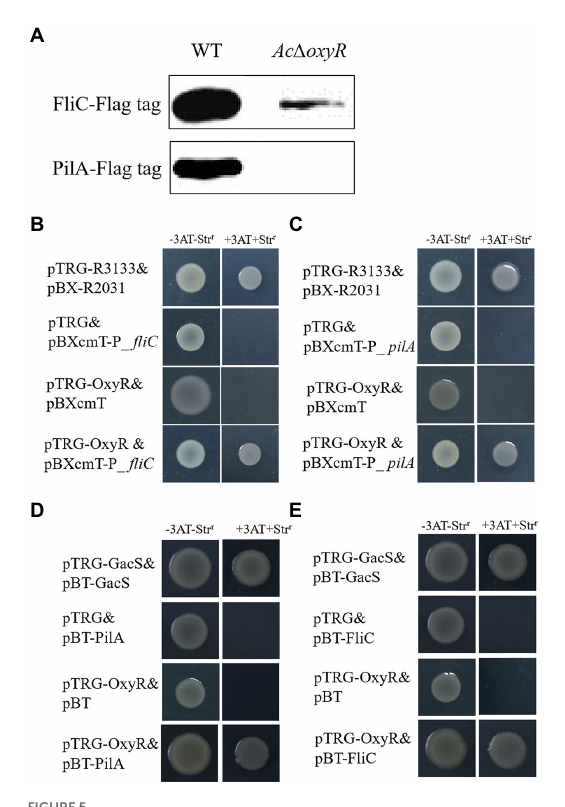
FIGURE 5 Expression of PilA and FliC directly affected by OxyR. (A) Abundance of FliC-Flag and PilA-Flag in the WT and Ac Δ oxyR were analyzed by western blot. (B) The direct physical